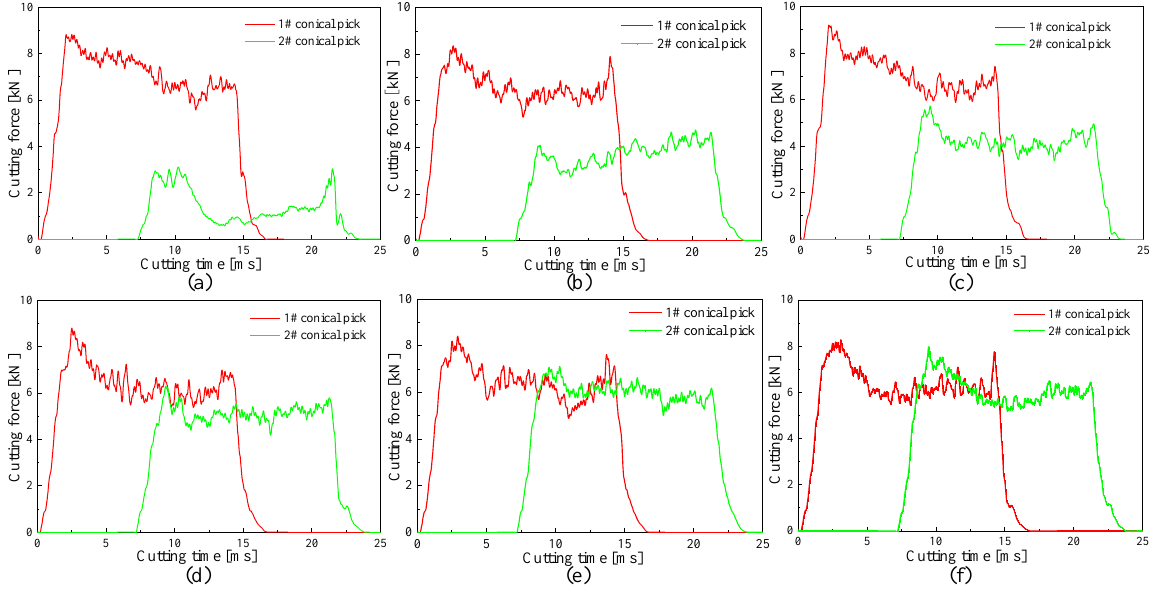
Figure 19. The cutting force curves of double conical picks with different distances: ( a ) 8 mm, ( b ) 15 mm, ( c ) 20 mm, ( d ) 25 mm, ( e ) 30 mm, and ( f ) 50 mm. The distance between double conical picks affects the cutting force greatly; as the cutting distance increases, the cutting force of the first conical pick increases gradually, but the cutting force of the second conical pick demonstrates no change. As the distance between double conical picks increases, the volumes of rock damage and rock breakage increase first and are still stable, as shown in Figure 20.